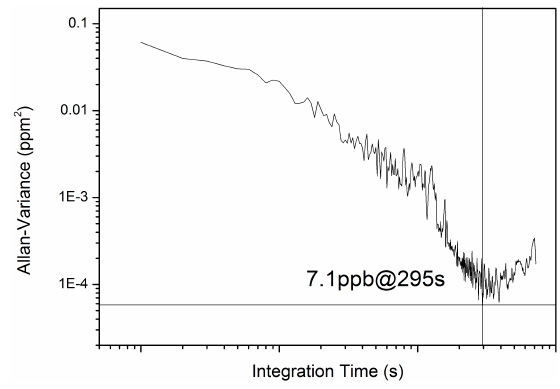
Figure 7. Allan variance plot for measured CH 3 SH (10 ppm).